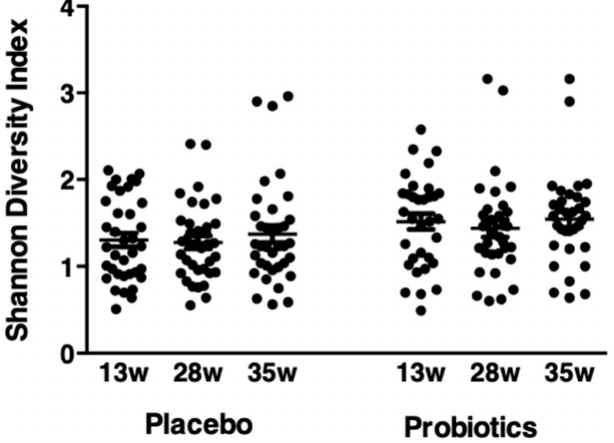
Figure 5. Shannon diversity index (SDI) across gestation in pregnant women who received either placebo or probiotic treatment. Results are mean values ± standard deviation (SD) and are expressed in ratios. Comparisons between the probiotic (n = 32) and placebo (n = 34) groups at 13, 28 and 35 weeks of gestation were assessed with Two-Way Repeated Measure Analysis of Variance (ANOVA) followed by the Holm–Sidak post hoc test ( p >